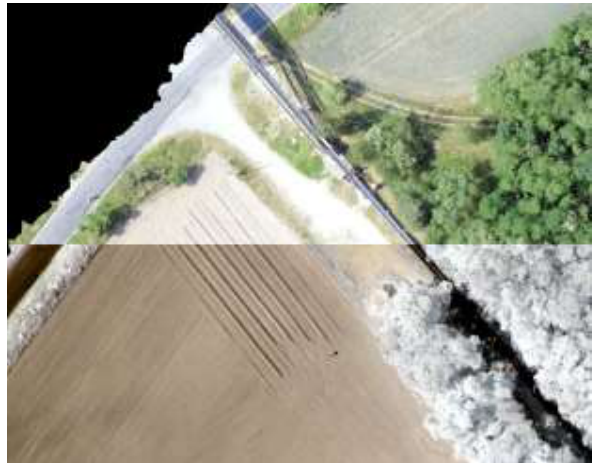
Figure 4. Precise geometric co-registration of VIS and NIR spectral channels